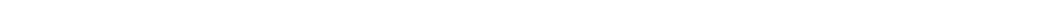
(see fi gure on previous page) Fig. 2 Δ 113p53 -positive radial glia cells undergo cell proliferation and contribute to the neuron renewal process. A Cryosections of EDU- labeled Tg( Δ 113p53:GFP) telencephalon were immunostained by anti-GFP (in green), anti-GFAP (in red), labeled-EDU in white, and nuclei with DAPI (in blue). The framed area in A was magni fi ed in A ’ , anti-GFP in A ” , labeled-EDU in A ”’ and anti-GFAP in A ”” . White arrow: GFP + /GFAP + /EDU + cells. Yellow arrows: GFP + /GFAP + cells; white arrowhead: EDU + /GFAP + cells. Scale bar in A , 50 μ m; Scale bar in A ’ , A ” , A ”’ , A ”” , 10 μ m. B Cryosections of Tg ( Δ 113p53:GFP) larva brain at 5 dpf were immunostained by anti-GFP (in green) ( B ’ ) and anti-GFAP (in red) ( B ” ) antibodies. Scale bar, 10 μ m. C – F Δ 113p53 -positive cells in Tg( Δ 113p53:CreER; β -act2:RSG) transgenic fi sh were genetically labeled at 5 dpf or at the adult stage by inducing Cre activity with 4-HT. The labeled larvae grew up to 6-months old and were subjected to immunostaining analysis ( C ), whereas the labeled adult fi sh were sampled at either 7 ( D ) or 23 dpt ( E ). Cryosections of labeled Tg( Δ 113p53:CreER; β -act2:RSG) telencephalon were immunostained by anti-GFP (in green), anti-GFAP (in red) antibodies in C . In D and E , the red fl uorescence was from the expression of en vivo DsRed. The nuclei were stained with DAPI (blue). The framed area in C was magni fi ed in C ’ (merged) , C ” (GFP), and C ”’ (GFAP). Framed areas in D and E were magni fi ed in D ’ and E ’ , respectively. Scale bar in C , D , E , 50 μ m; Scale bar in C ’ , C ” , C ”’ , 20 μ m; Scale bar in E ’ , F ’ , 10 μ m. The average number of GFP + radial glia cells per 100 μ m along the ventricle zone of Tg( Δ 113p53:CreER; β -act2:RSG) telencephalon at 7 and 23 dpt was represented in F . Each dot represents the average number of GFP + radial glia cells per 100 μ m of the ventricular zone (VZ) in one section. The middle region of each telencephalon (about three to six sections) was used for the counting and three telencephalons were sampled in each group. Statistical analysis was performed on relevant data using the Student ’ s two-tailed t test. *** P <